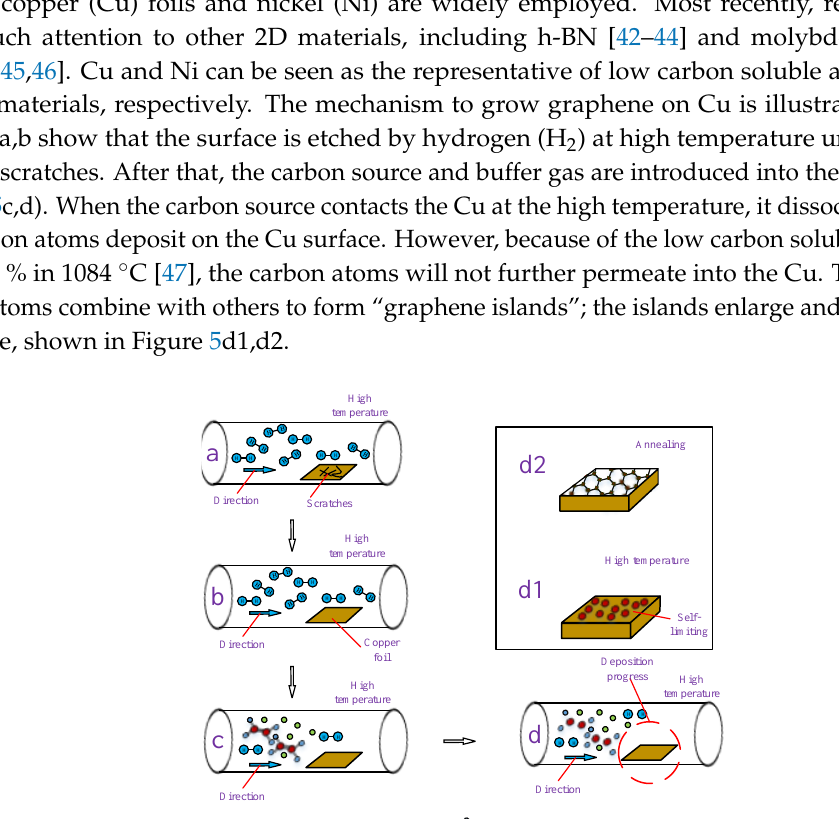
Figure 6. Mechanism of CVD growth graphene on Ni.